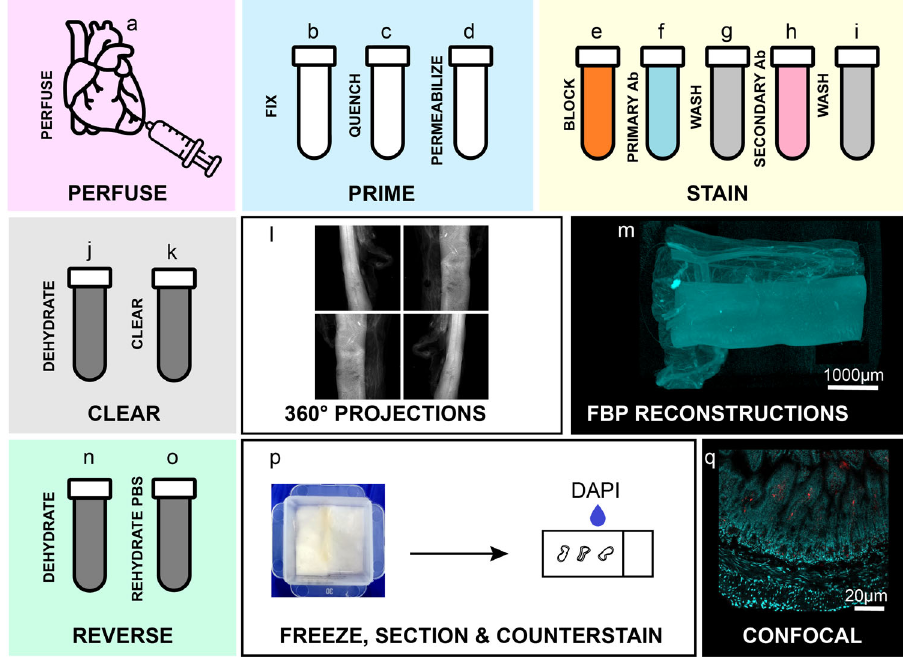
Fig. 1 gutOPT work fl ow. Sample preparation and handling in four steps: sample preparation ( a – k ), imaging and image processing ( l , m ), reverse-OPT ( n – p ) and secondary imaging ( q ). The experimental steps for sample preparation are: transcardiac perfusion of PBS and 4% PFA ( a ); 4-hour PFA fi xation ( b ); overnight auto fl uorescence quenching with methanol, DMSO and hydrogen peroxide 1:3:2 mixture ( c ); permeabilisation by three freeze-thaw cycles between − 80 °C (1 h) and room temperature (30 min) ( d ); 24-hour tissue blocking ( e ); 48-hour primary antibody incubation ( f ); 24-hour wash ( g ); 48- hour secondary antibody incubation ( h ); 24-hour wash ( j ); 36-hour dehydration in pure methanol with two solution changes ( j ) and clearing in 1:2 ratio of benzyl alcohol and benzyl benzoate ( k ). Optical projections are acquired over a 360° rotation of the sample ( i ) and a 3D image is reconstructed using fi ltered back projection ( m ). OPT processing may be reversed in order to image sections of the same sample using alternative imaging modalities. To do so, samples are dehydrated in pure methanol for 36 hours ( n ), rehydrated in PBS ( o ), mounted in cryomatrix, cryo-sectioned and counterstained with DAPI ( p ). High-resolution imaging modalities such as confocal microscopy ( q ) may be applied to samples whose large-scale volume has been